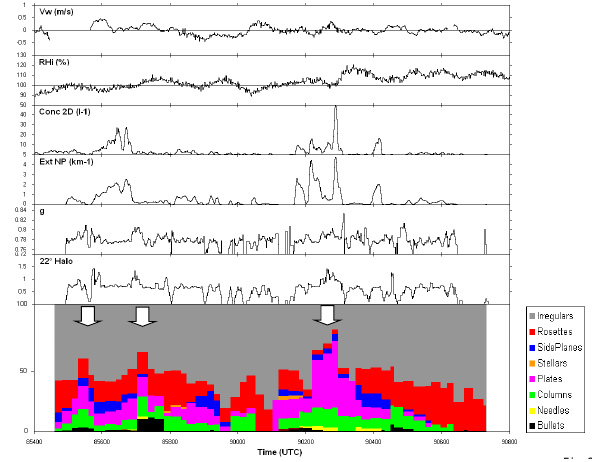
Fig. 3. Same as in Fig. 1. Time-series of in situ parameters obtained on 16 May in cirrus cloud at 7200m/ − 27 ◦ C. The relative humidity (over ice) is also